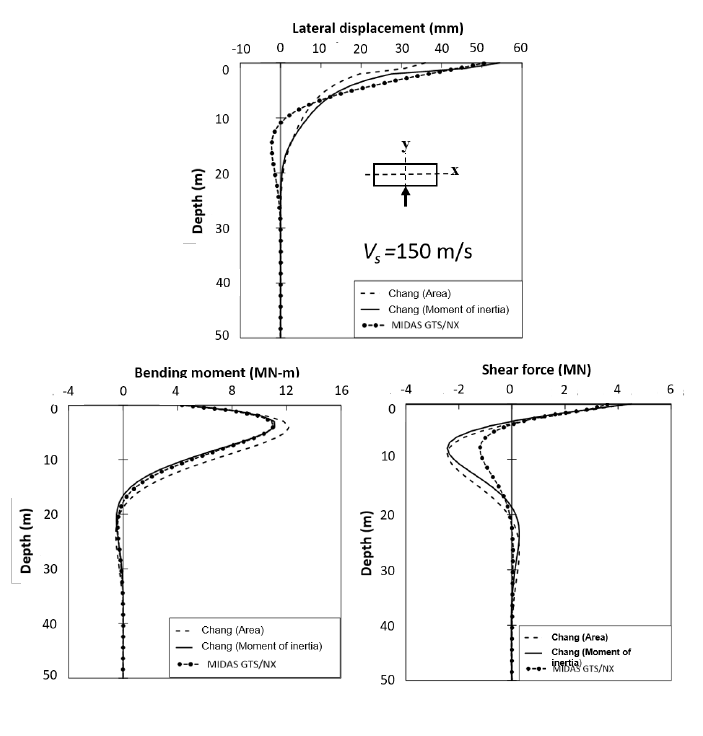
Fig. 21. Comparative solutions for barrette in sands with load in transverse direction